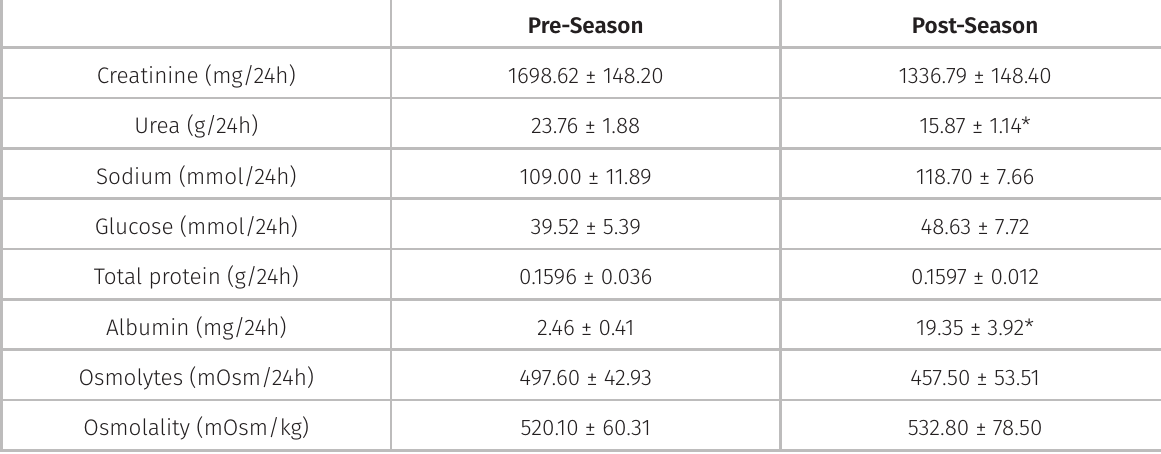
Table II. Urinary solutes excretion (Mean ±